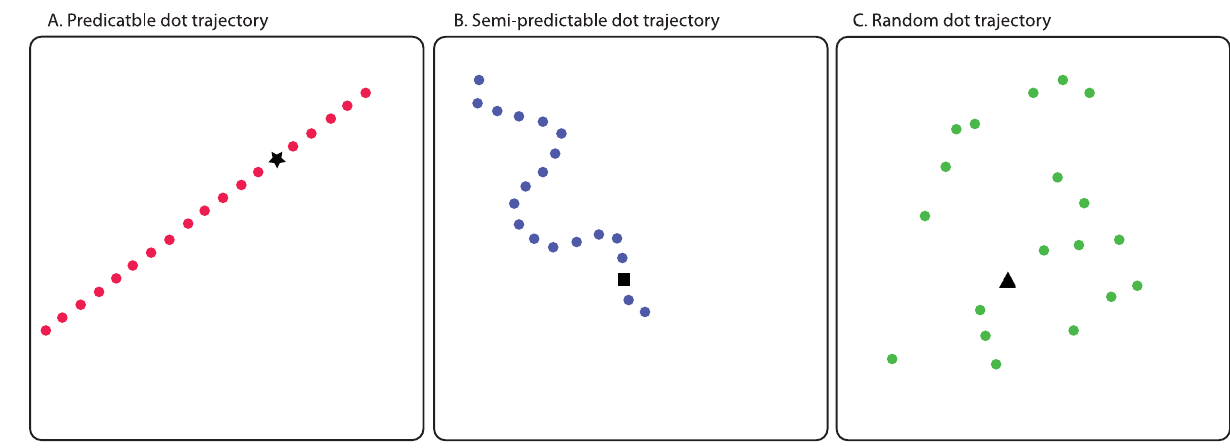
Fig 2. Examples of dot trajectoriesdepending on their predictability. Predictabledot trajectory stayed the same throughoutthe study, whilesemi-predictable and random dot trajectories different from trial to trial. Only one dot was visibleat a time.